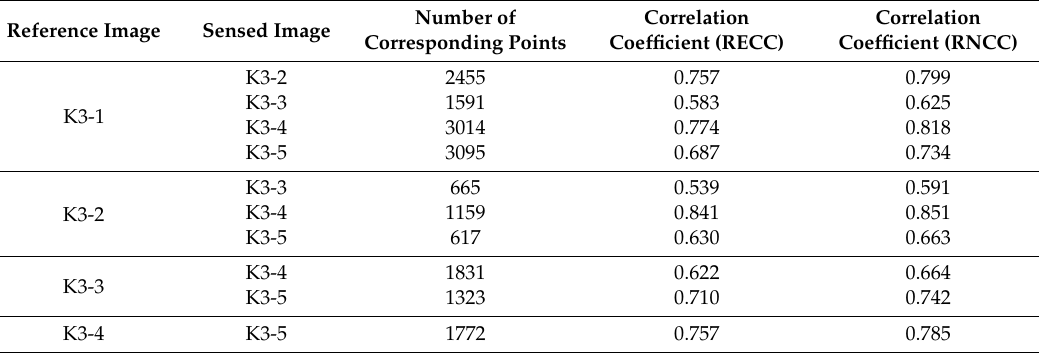
Table 3. Accuracy assessment of georegistration and co-registration results. RECC—relative edge cross-correlation; RNCC—registration noise-based